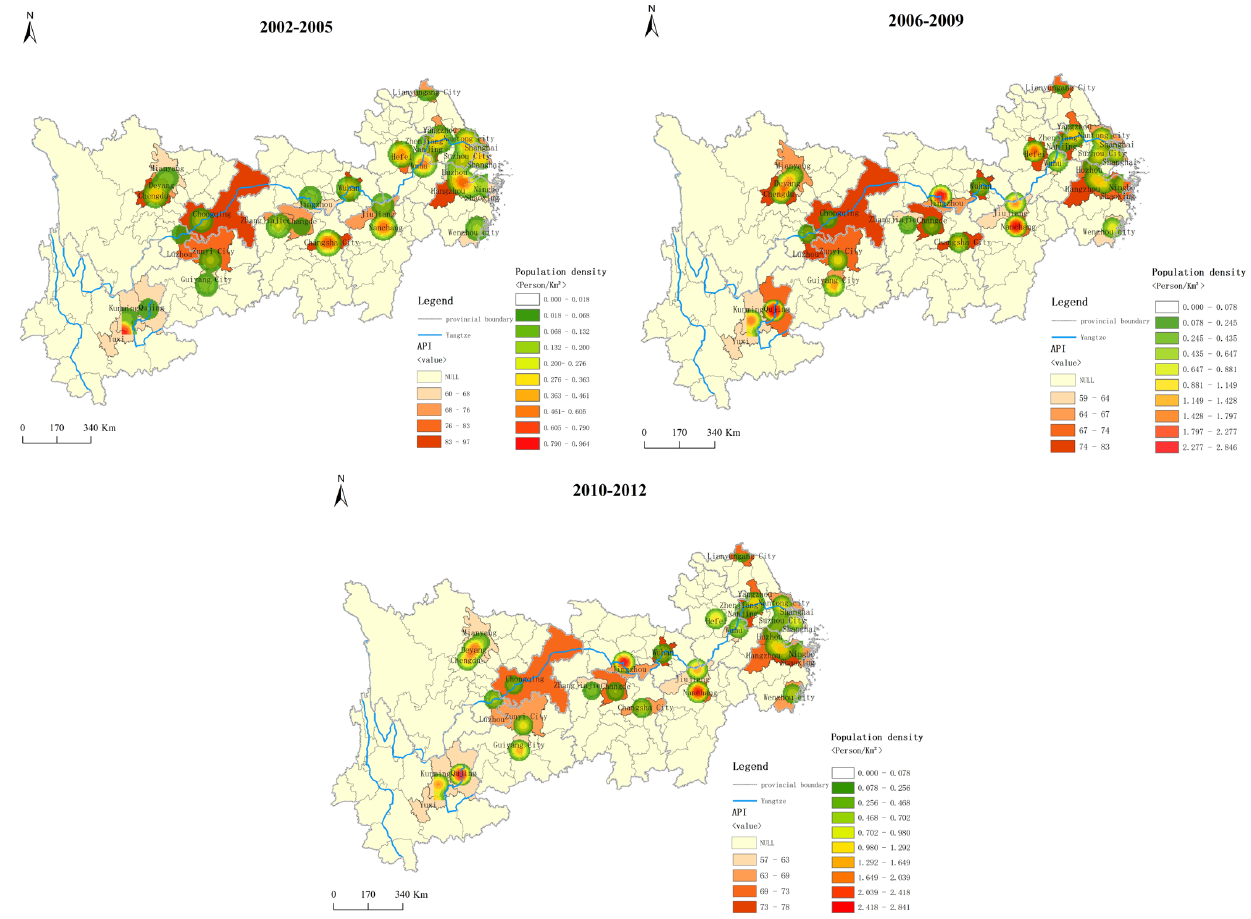
Figure 3. Regional differences of air pollution in the YREB from 2002–2012.